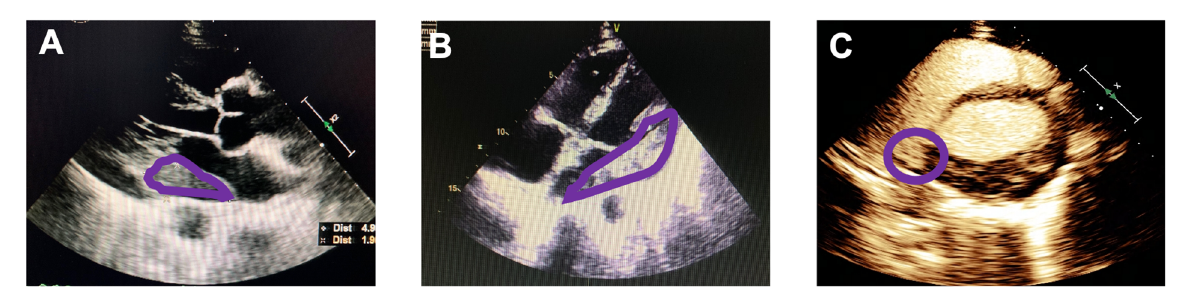
FIGURE 1 Echocardiography imaging: ( A ) parasternal long axis section; ( B ) four-chamber section. An intracardiac echogenic mass (in the purple circles) 50 mm×67 mm×19 mm was visualized at the left atrioventricular junction outside the cardiac cavity. ( C ) Left ventriculography and myocardial contrast echocardiography showed an abundance of contrast agent fi lling into left ventricular and the mass.